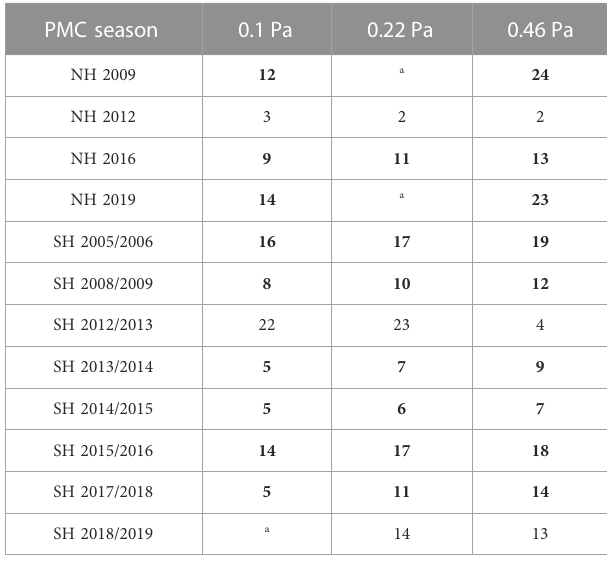
TABLE 2 Average time lag (in days) of temperature response to the 27-day solar rotational modulation in the latitude range 53 ° – 81 ° at different atmospheric pressure values.